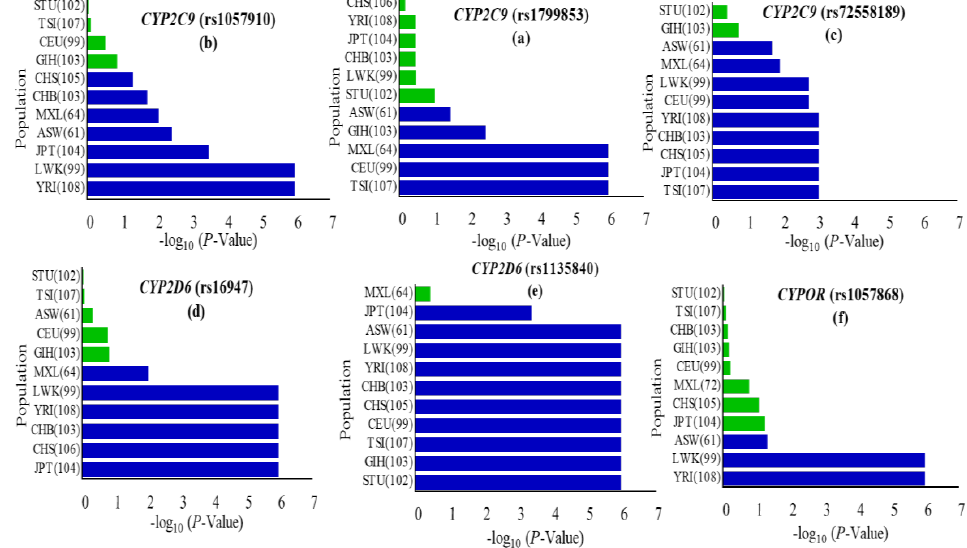
Figure 1. Occurrence of cytochrome P450 2C9 ( CYP2C9) , cytochrome P450 2D6 ( CYP2D6)